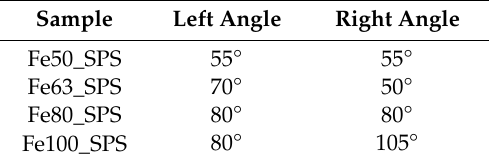
Figure 7. Trend of the contact angle as a function of time of pure Sn on ( a ) Fe50_SPS, ( b ) Fe630_SPS, ( c ) Fe80_SPS, and ( d ) Fe100_SPS.